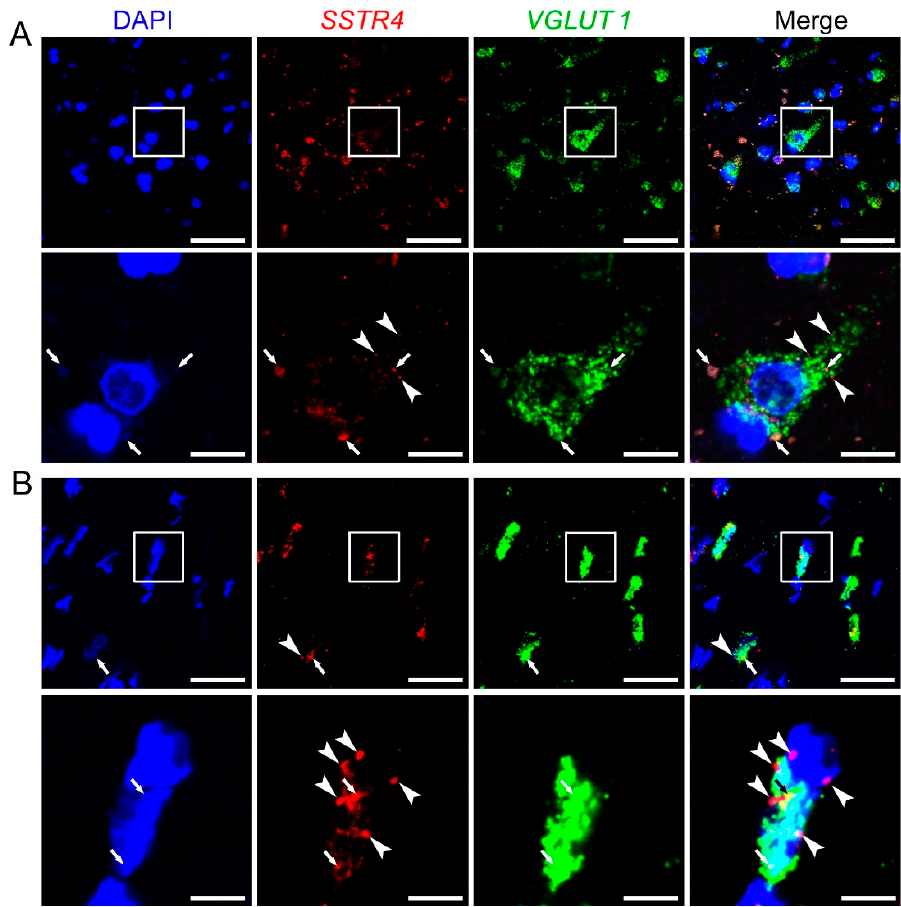
Figure 8. Representative SSTR4 and VGLUT1 mRNA expression of layer V pyramidal neurons of human neurosurgical cortical samples taken from the left middle temporal gyrus (by multiplex fluorescent RNAscope in situ hybridization (ISH)). Panel ( A ) shows images from Sample A of a 56-year-old man. Note that the tissue contains considerable amount of lipofuscin that shows some autofluorescence in all examined channels (arrows). Granular fluorescence pattern that occurs in one color only represents the respective specific RNAscope ISH signal for VGLUT1 (green) or SSTR4 (red, marked in part by arrowheads) counterstained with DAPI (blue). Panel ( B ) depicts images of Sample B taken from a 19-year-old woman. Note the relatively low aging pigment content (arrows) of the VGLUT1 (green) expressing layer V pyramidal cells, which contain SSTR4 mRNA (arrowheads) also, counterstained with DAPI (blue). Cellular and nuclear (DAPI) morphology in Sample B differs from that of Sample A, as Sample B was fresh frozen before fixation, in contrast to Sample A that was subjected to immediate immersion fixation in 10% neutral buffered formalin. Boxed areas in the top images (scale bar: 100 µm) of both panels are shown in higher magnification photos right bellow (scale bar: 25 µm).